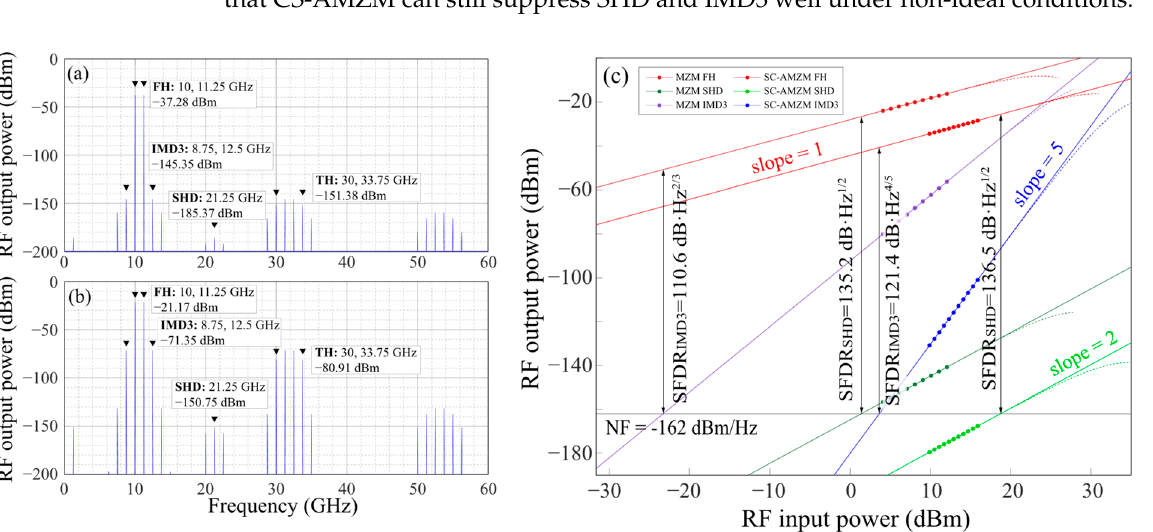
Table 3. Comparison of the reported modulators on TFLN platforms.